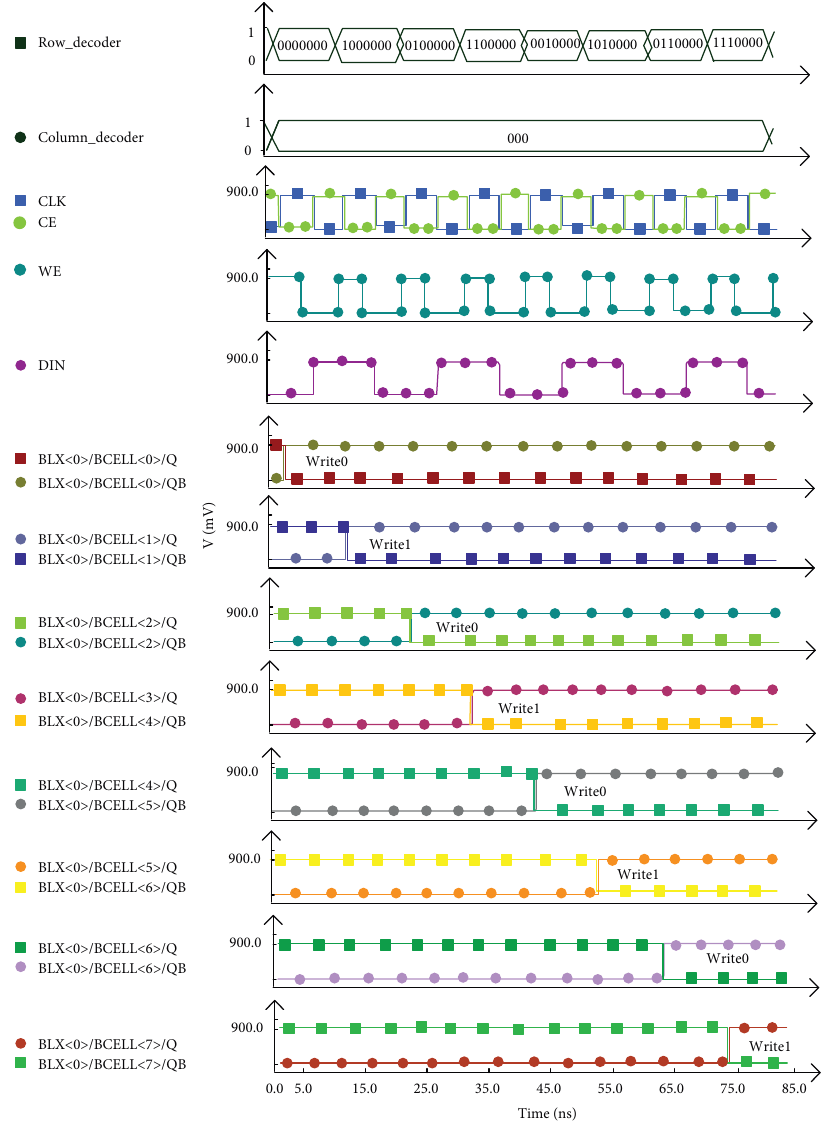
Figure 12: Result of writing data to 8